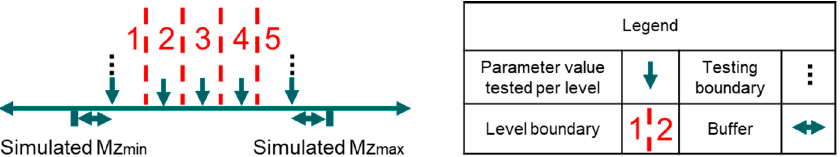
Figure 4. Illustration of an example factor range with factor levels and testing boundaries.